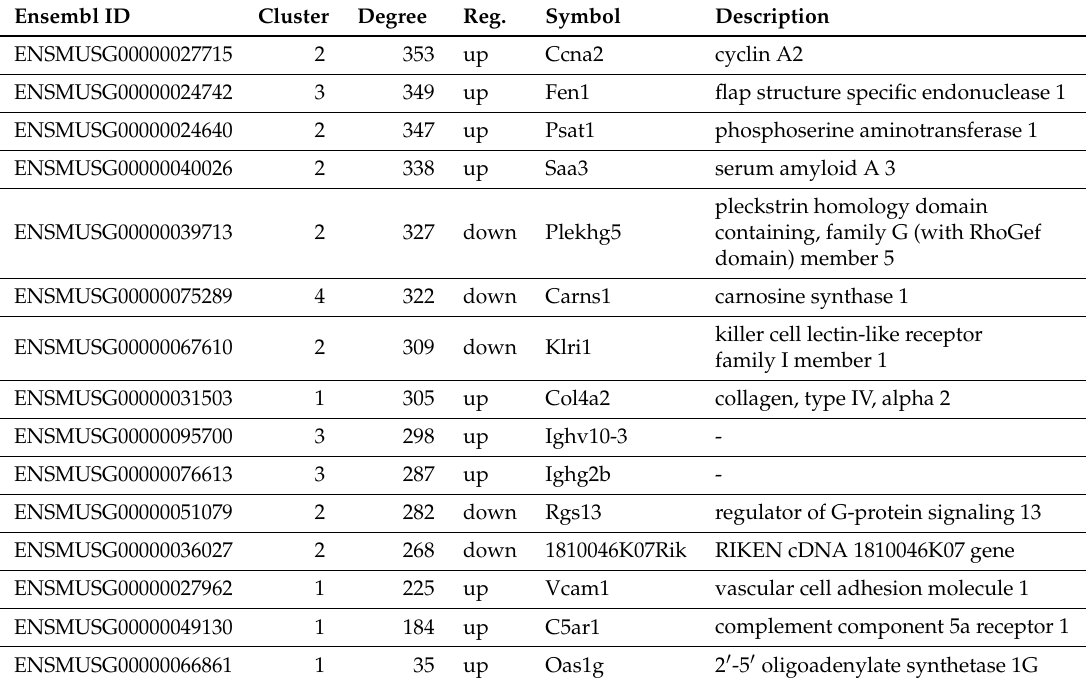
Table A5. Hubs identified in the network reconstructed from spleen Ly6E ∆ HSC samples. Degree cutoff: